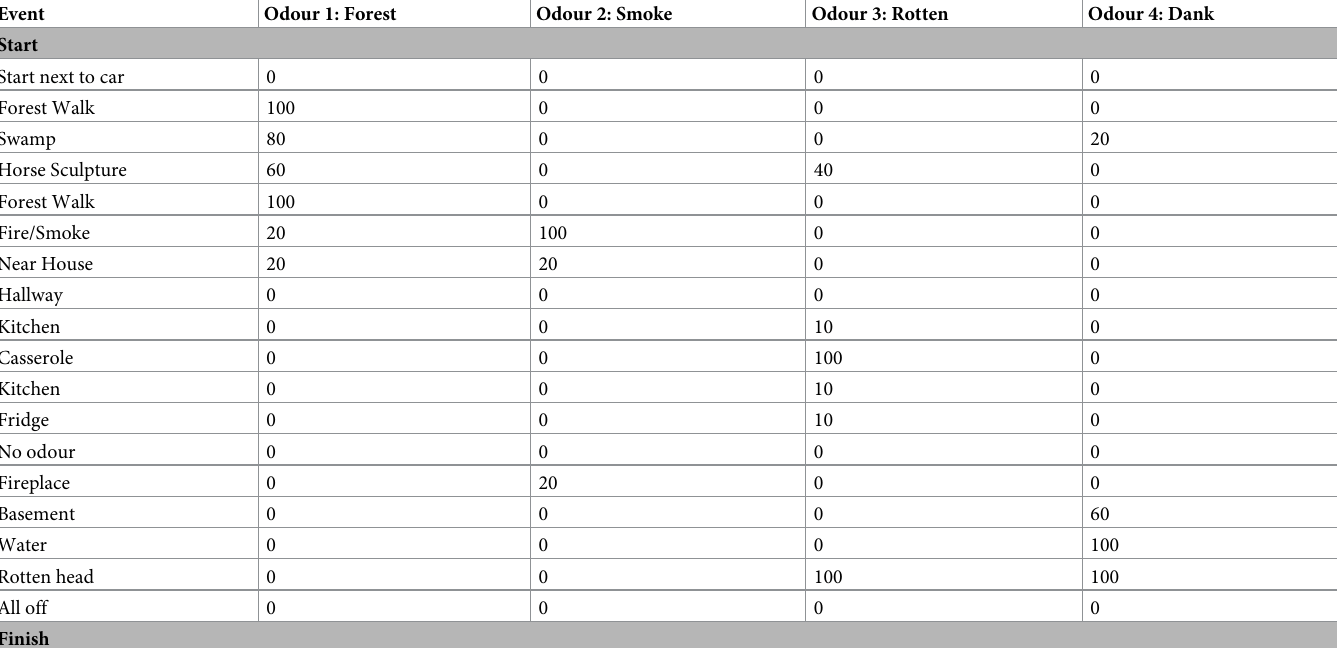
Table 2. List of the gameplay events and the percentage of each odour mixed together and delivered to the participant a